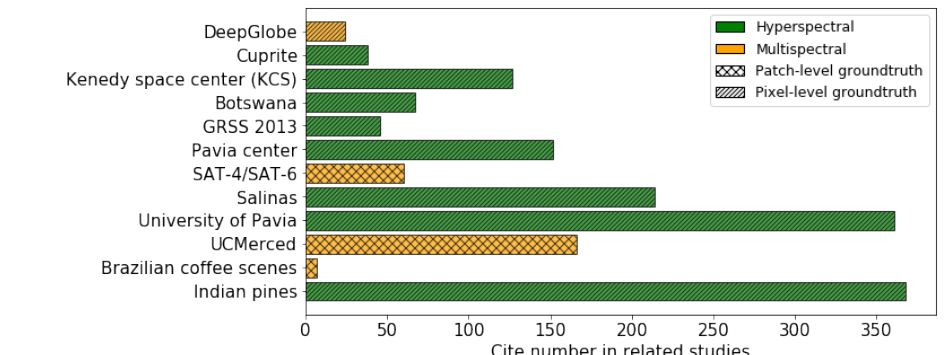
Figure 4. The most popular datasets for land cover classification purposes employing deep learning techniques. This graph is based on the number of papers referencing the datasets by May